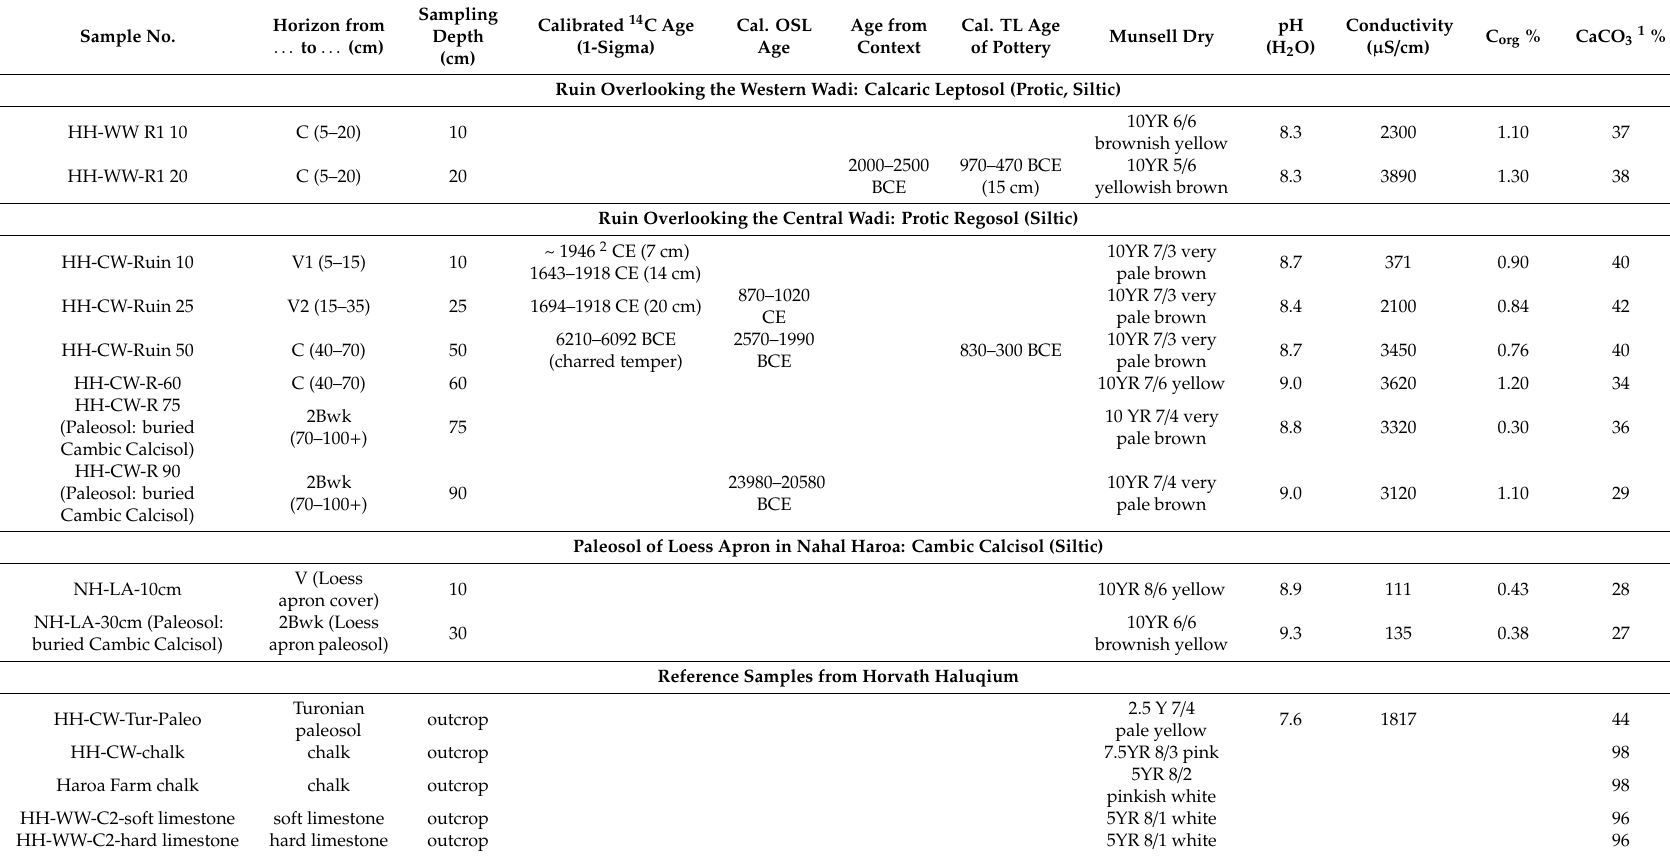
Table 2. General properties and calibrated ages of the Negev profiles and